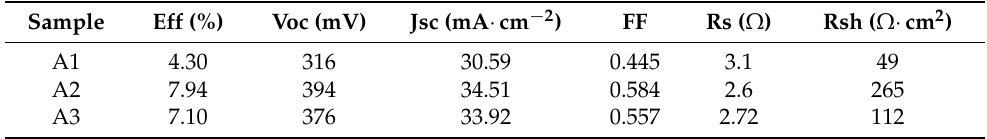
Figure 10. Current-voltage (I-V) curves of three CZTSe solar cells by using films that were formed by the selenization of the precursor with samples A1, A2, and A3. Table 3. Performance parameters of CZTSe solar cells that were prepared by the precursor samples of A1, A2, and